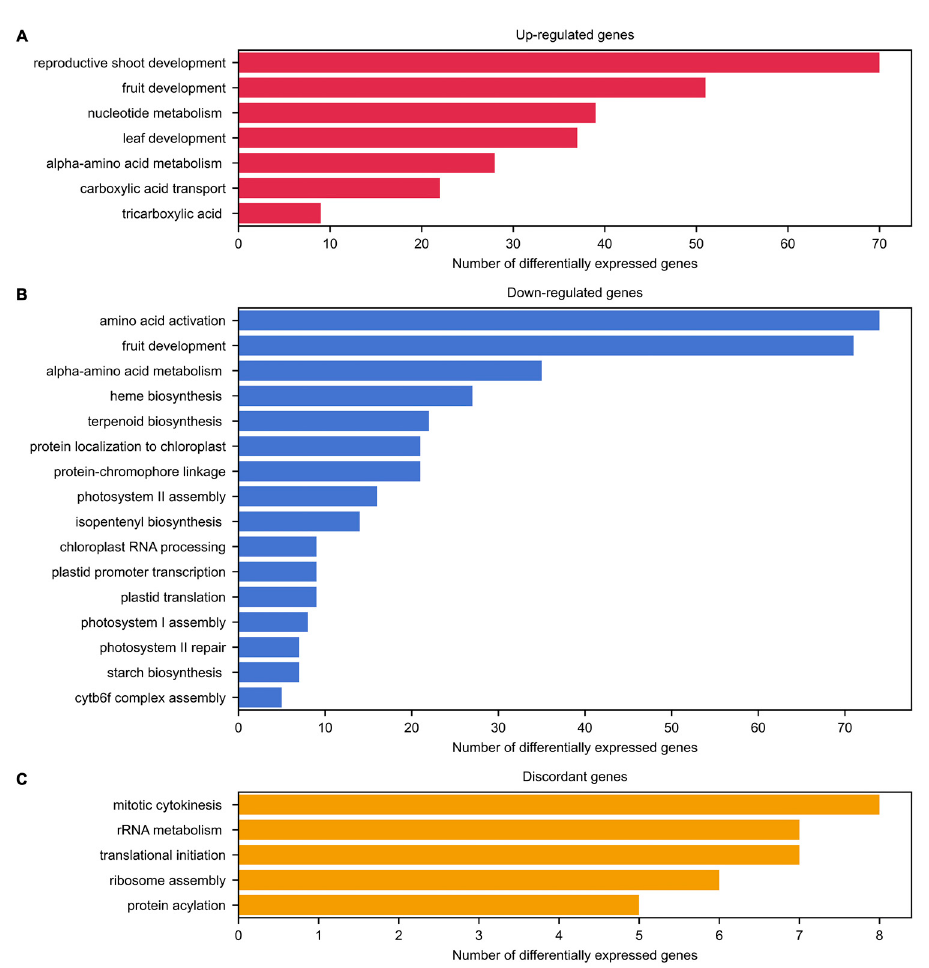
Figure 3. Biological processes in which differentially expressed genes are involved. The categories of GO terms for biological processes that are over-represented in each set of differentially expressed genes are the following: common up-regulated ( A ) and down-regulated ( B ) genes, and discordant genes ( C ), in the inflorescence meristem (IM) with respect to the vegetative meristem (VM) in PHA1037 and PHA0595. Details of this ontological annotation can be found in Tables S12–S14.